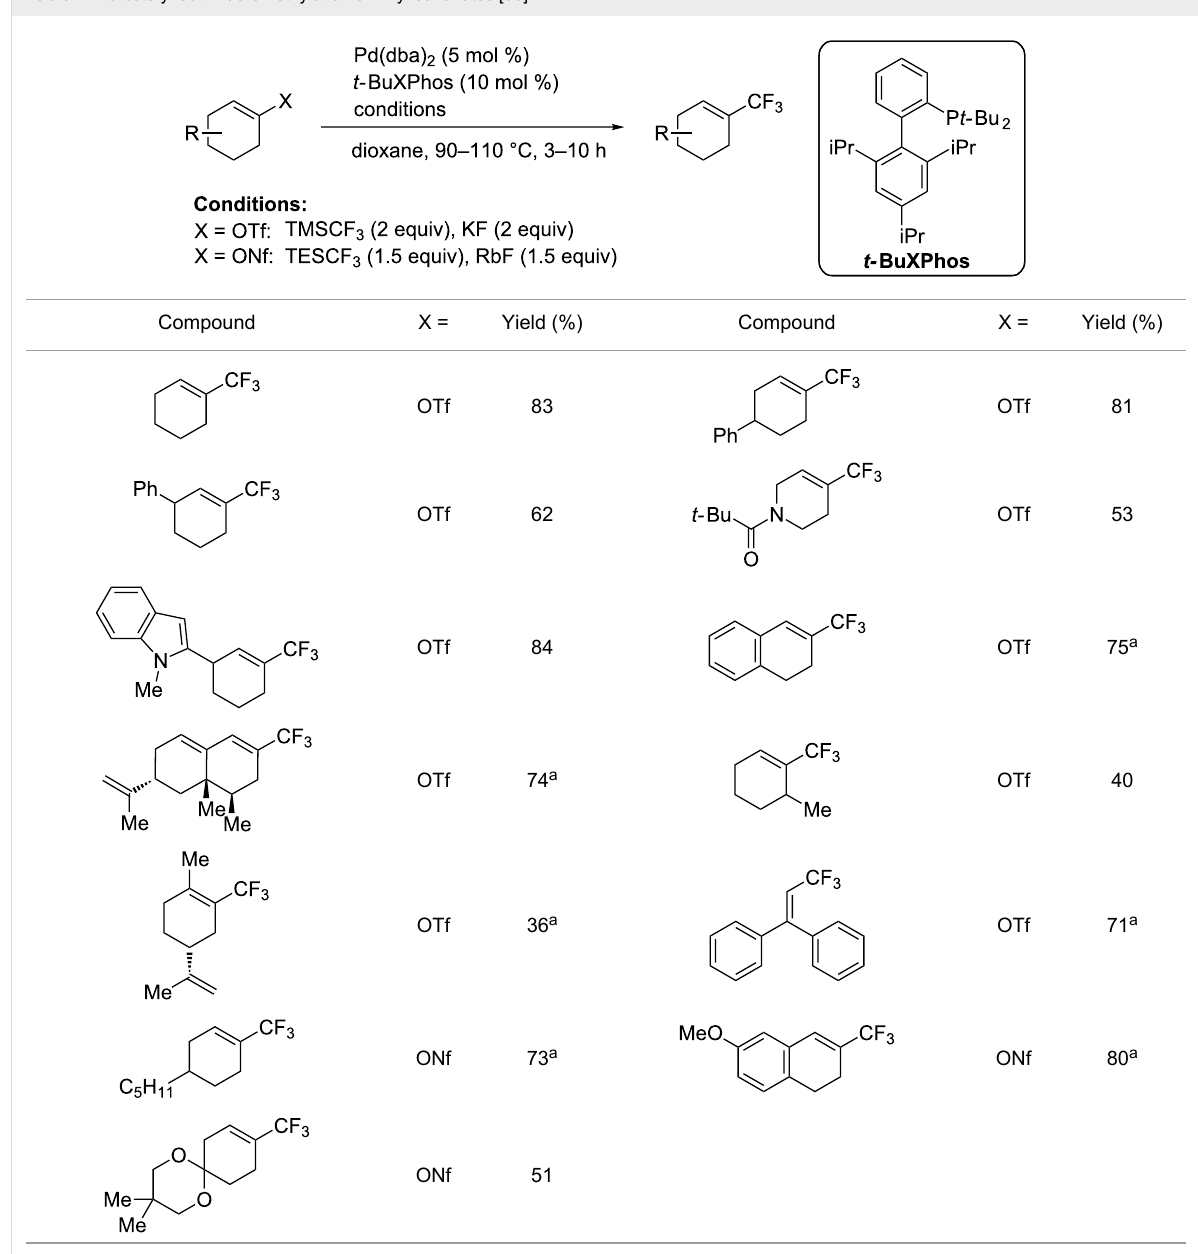
Table 4: Pd-catalyzed trifluoromethylation of vinyl sulfonates